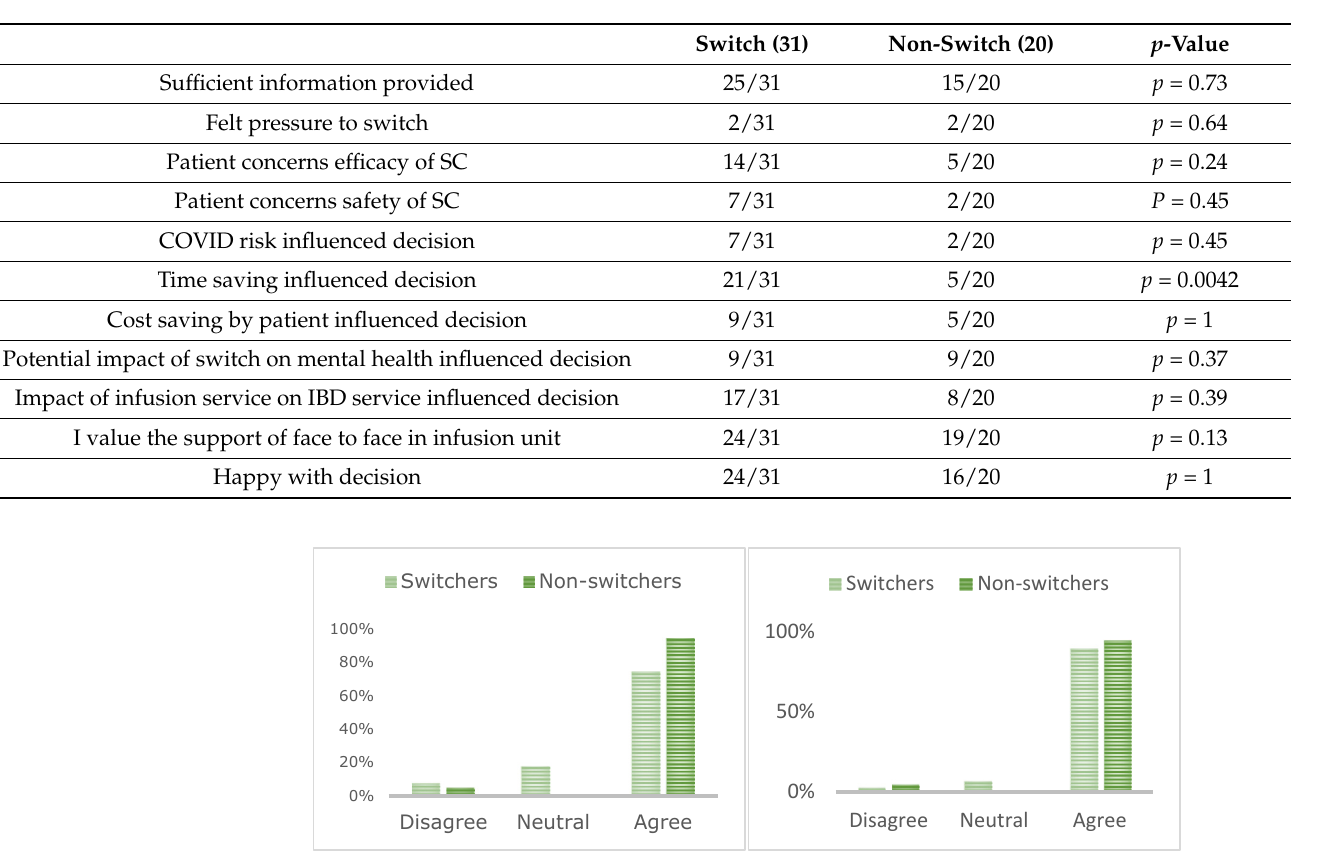
Figure 1. Patients who value face-to-face contact at the IBD unit ( left ) and those who utilise this time to seek support for management of their IBD ( right ).